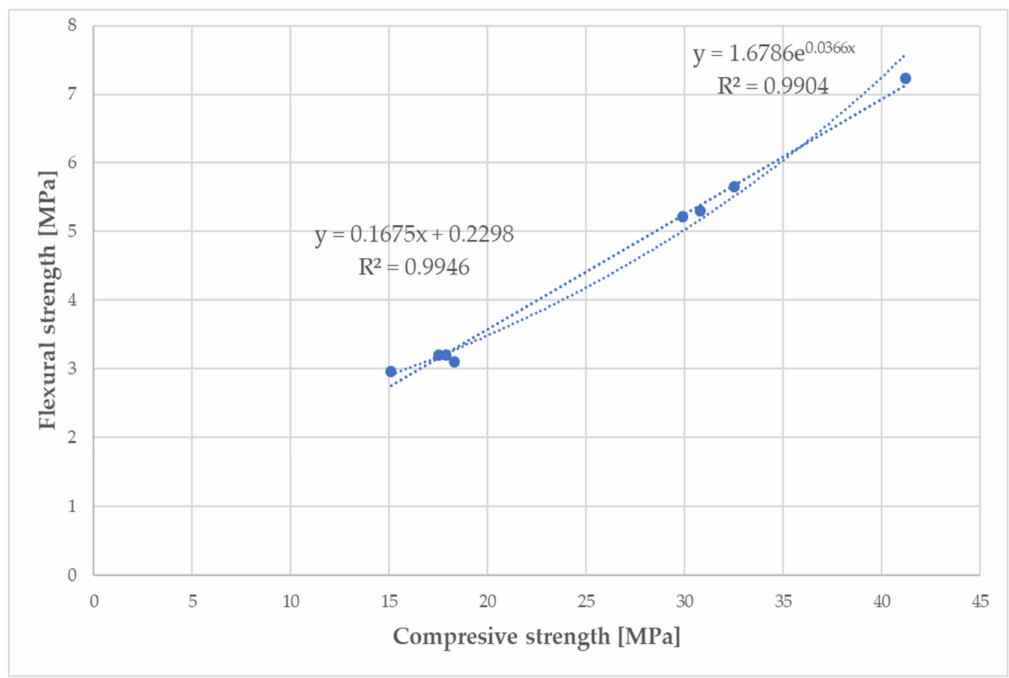
Figure 20. Relationship between flexural and compressive strength of fiber-cement mortars